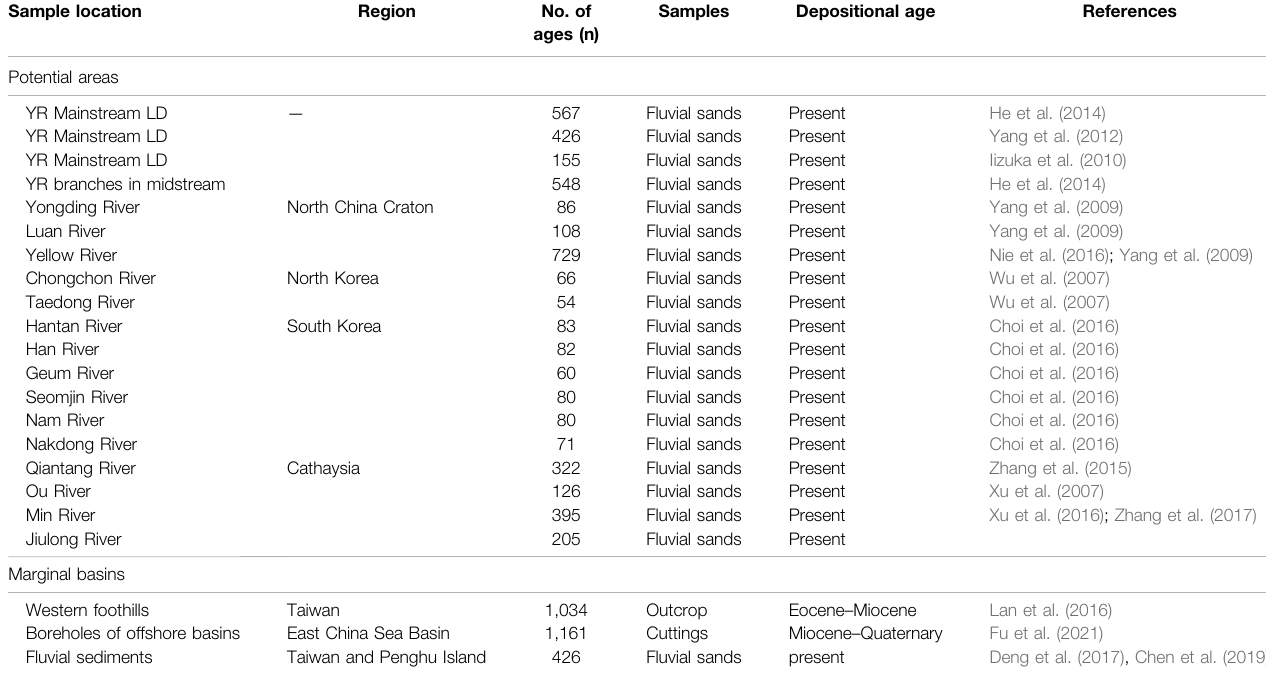
TABLE 1 | Compilation of detrital zircon ages for provenance analysis. Sample